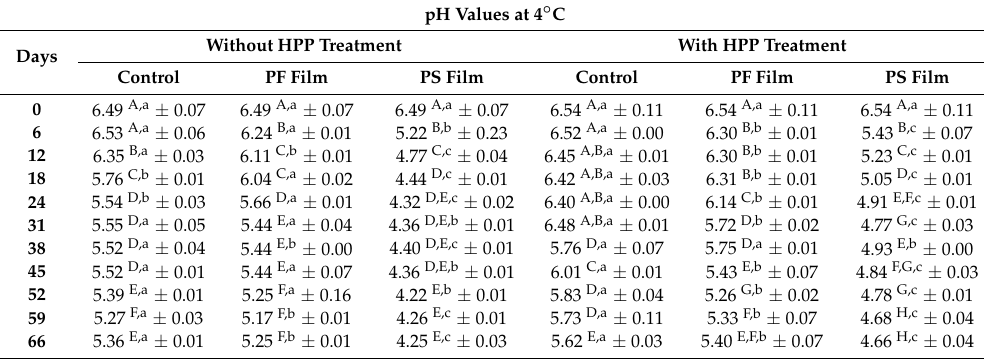
Table 1. Changes in pH values for ham slices treated or not with HPP, during storage at 4 ◦